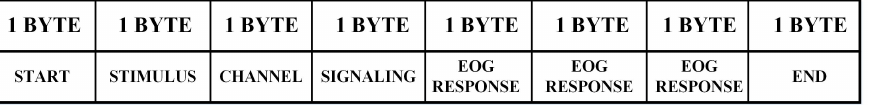
Figure 15. Multi-frame with the stimulus and EOG signal sent from the FPGA to the fixed